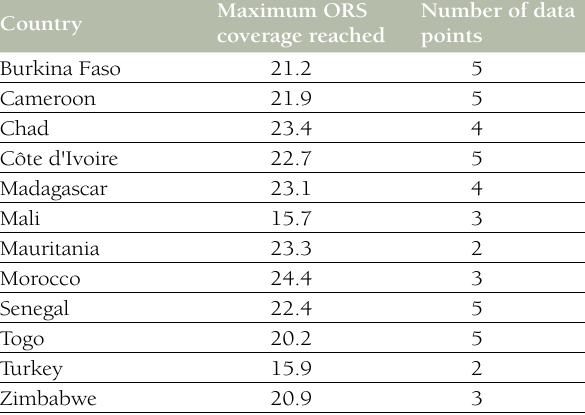
Table 3. Countries meeting the criteria for “non–starters”